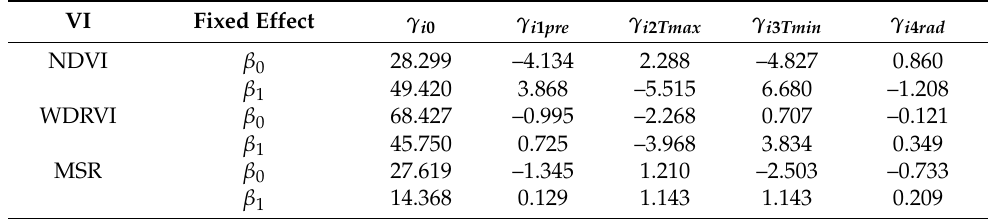
Table 5. Coefficient value of each variable in hierarchical linear modeling (HLM) for yield predic ‐ tion.